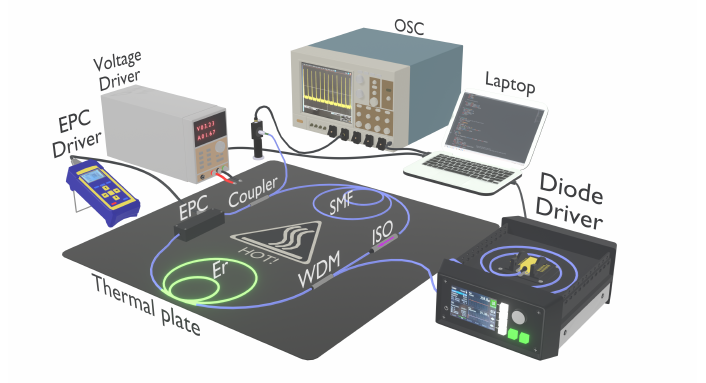
Figure 1. Experimental setup of the fiber mode-locked laser and measuring system.